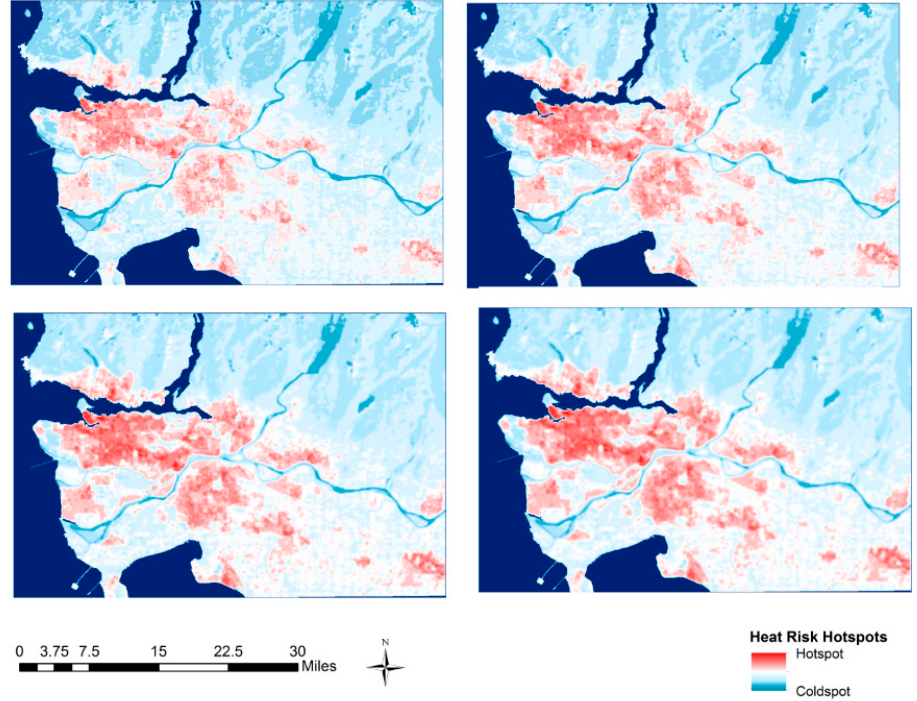
Figure 6. Comparison of heat risk hotspot maps produced with lag distances ranging from one pixel ( Top Left ) to four pixels ( Bottom Right ). Central Burnaby and East Vancouver (labelled in Figure 2) is known to have relatively high social vulnerability [63] and heat exposure [30], and contains the large heat risk hotspot in the study area.